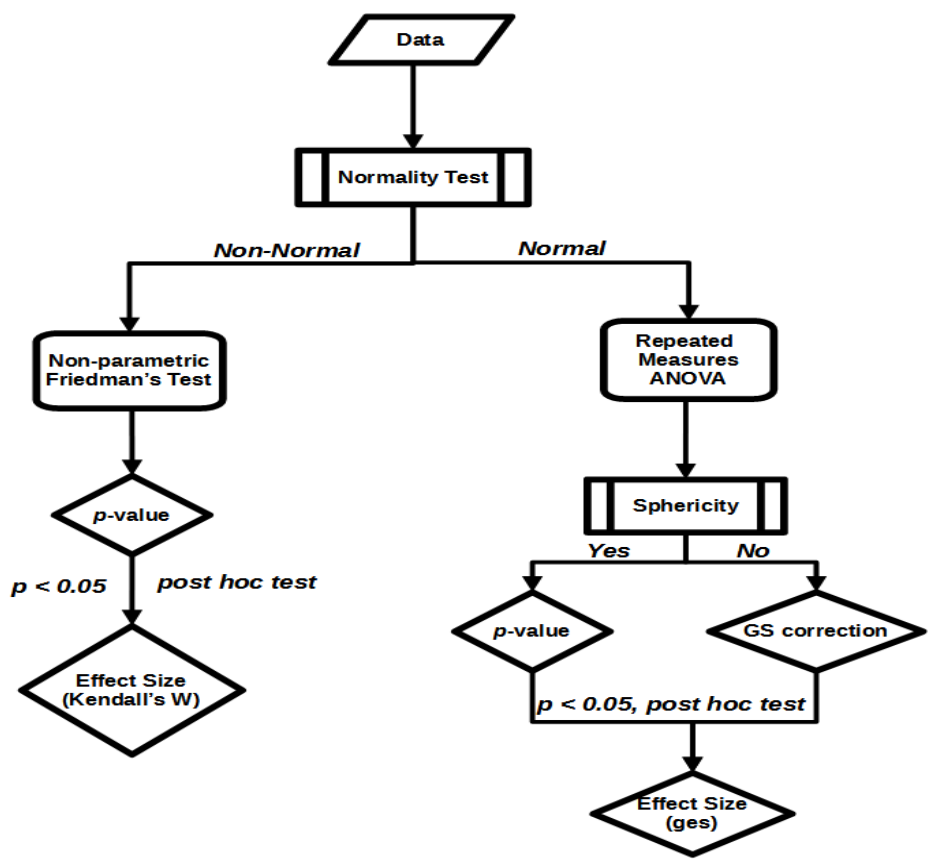
Figure 1. The flowchart of the statistical methodology and respective procedures considered in this study.